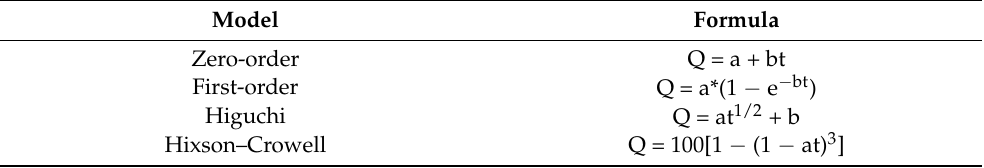
Table 1. The formula of drug release kinetics model. Model Formula